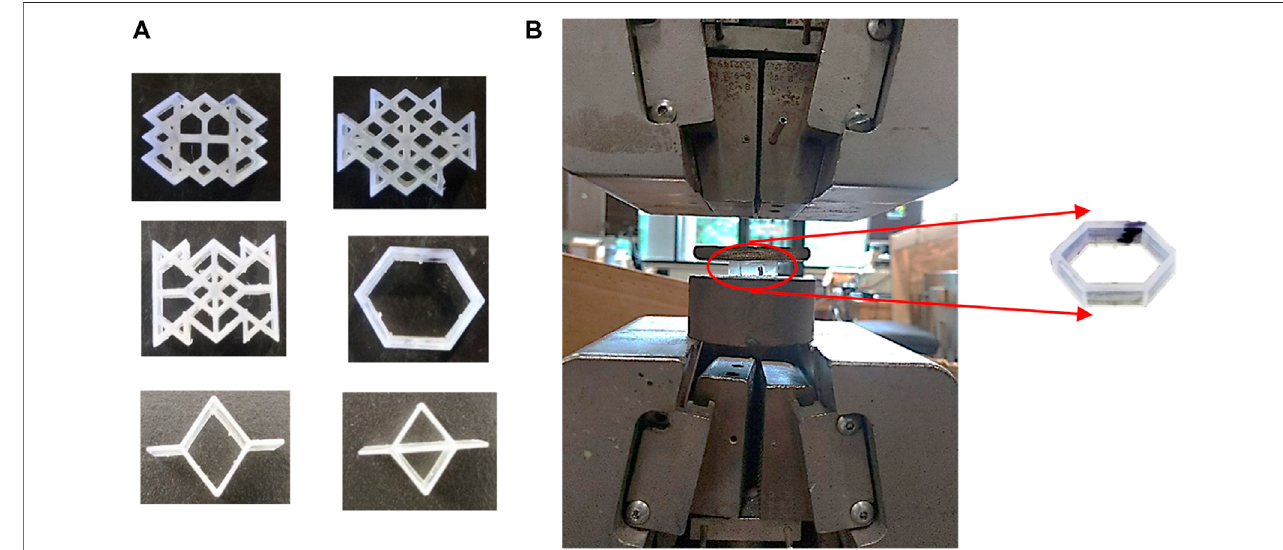
FIGURE 4 | Additively manufactured (A) cellular unit cells and (B) Uniaxial compression.